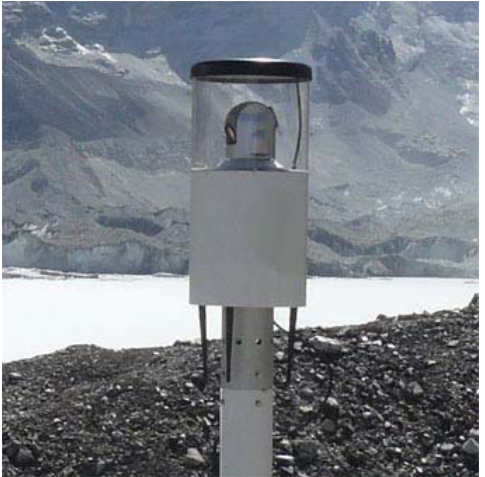
Figure 1. Typical